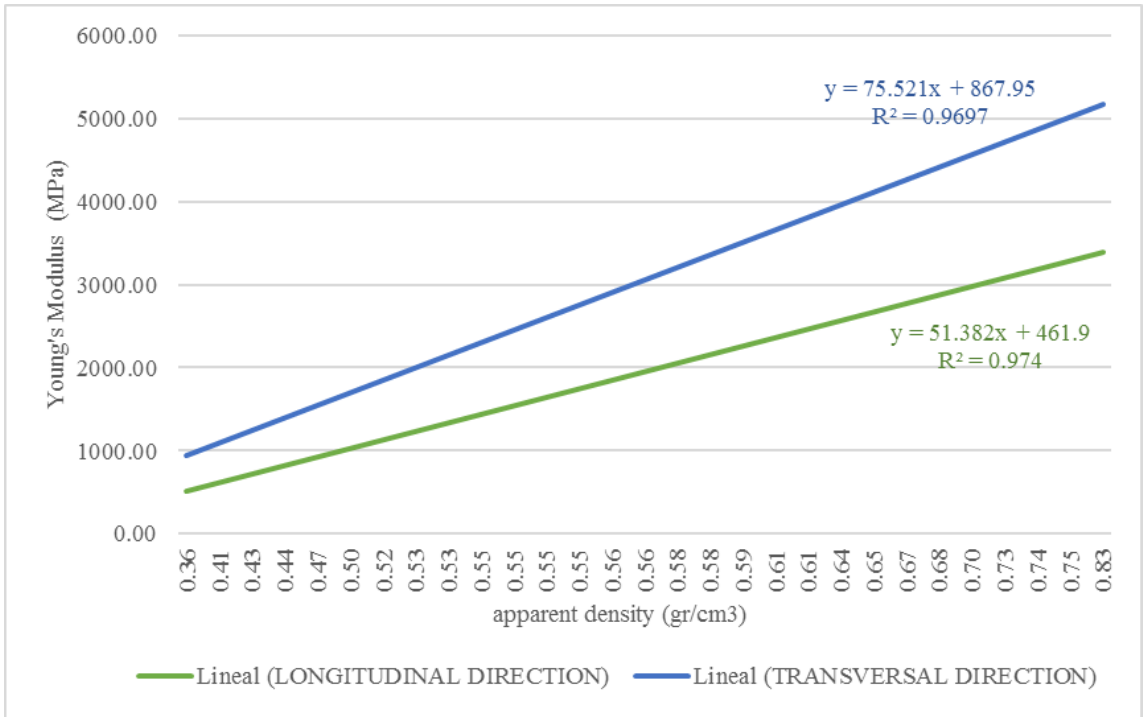
Figure 5. Relationship between apparent density and Young’s modulus for cortical tissue affected with OI in the longitudinal and transversal direction.